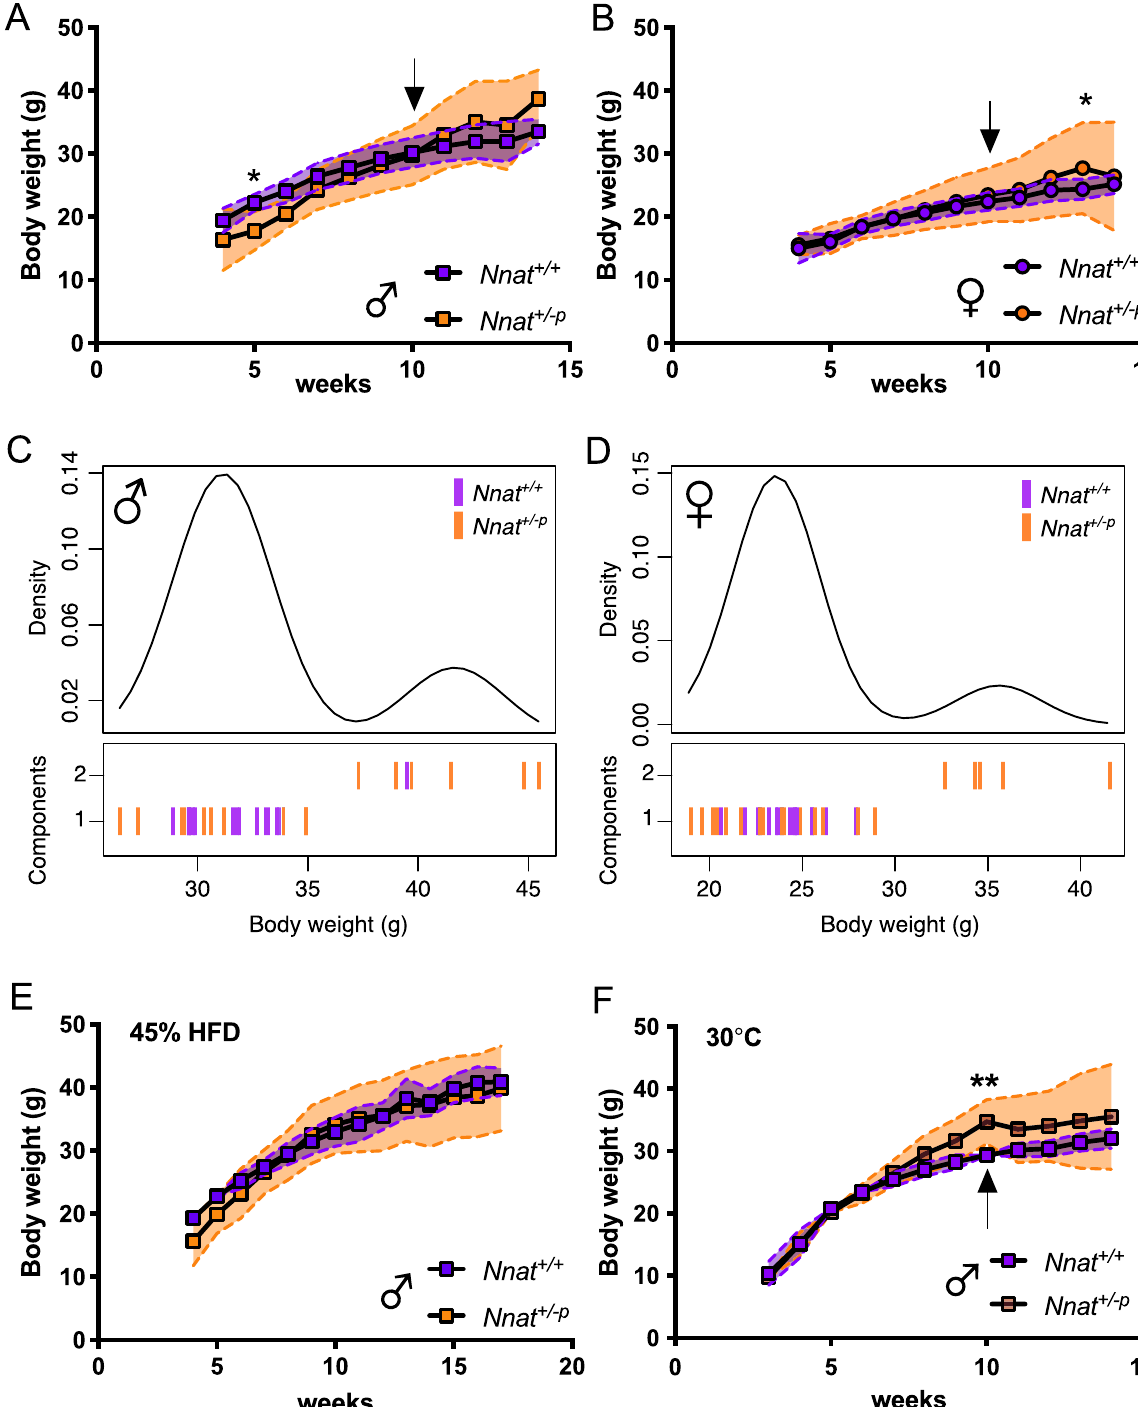
Figure 1. Nnat deficient mice have a highly variable body weight phenotype. Body weight over time of Nnat + / + and Nnat + /−p ( A ) male and ( B ) female mice on standard chow diet (at least 7 mice were included in each time point per genotype). Black arrow indicating time of the initiation of single housing. Mclust clustering showed significant variance of body weight at 12 weeks of age between Nnat + / + and Nnat + /−p male ( C ) and females ( D ) mice (male; Nnat + / + (n = 19), Nnat + /−p (n = 17): females; Nnat + / + (n = 16), Nnat + /−p (n = 21)). ( E ) Body weight over time of Nnat + / + and Nnat + /−p male mice fed 45% HFD (at least 7 mice at each time point per genotype). ( F ) Body weight over time of Nnat + / + and Nnat + /−p male mice at thermoneutral condition (30 °C) fed on standard chow diet (at least 7 mice at each time point per genotype). Black arrow indicating time of the initiation of single housing. Data are expressed as mean (square-circle points) ± SD (dotted lines), * P < 0.05; ** P < 0.01, 2-way ANOVA with multiple